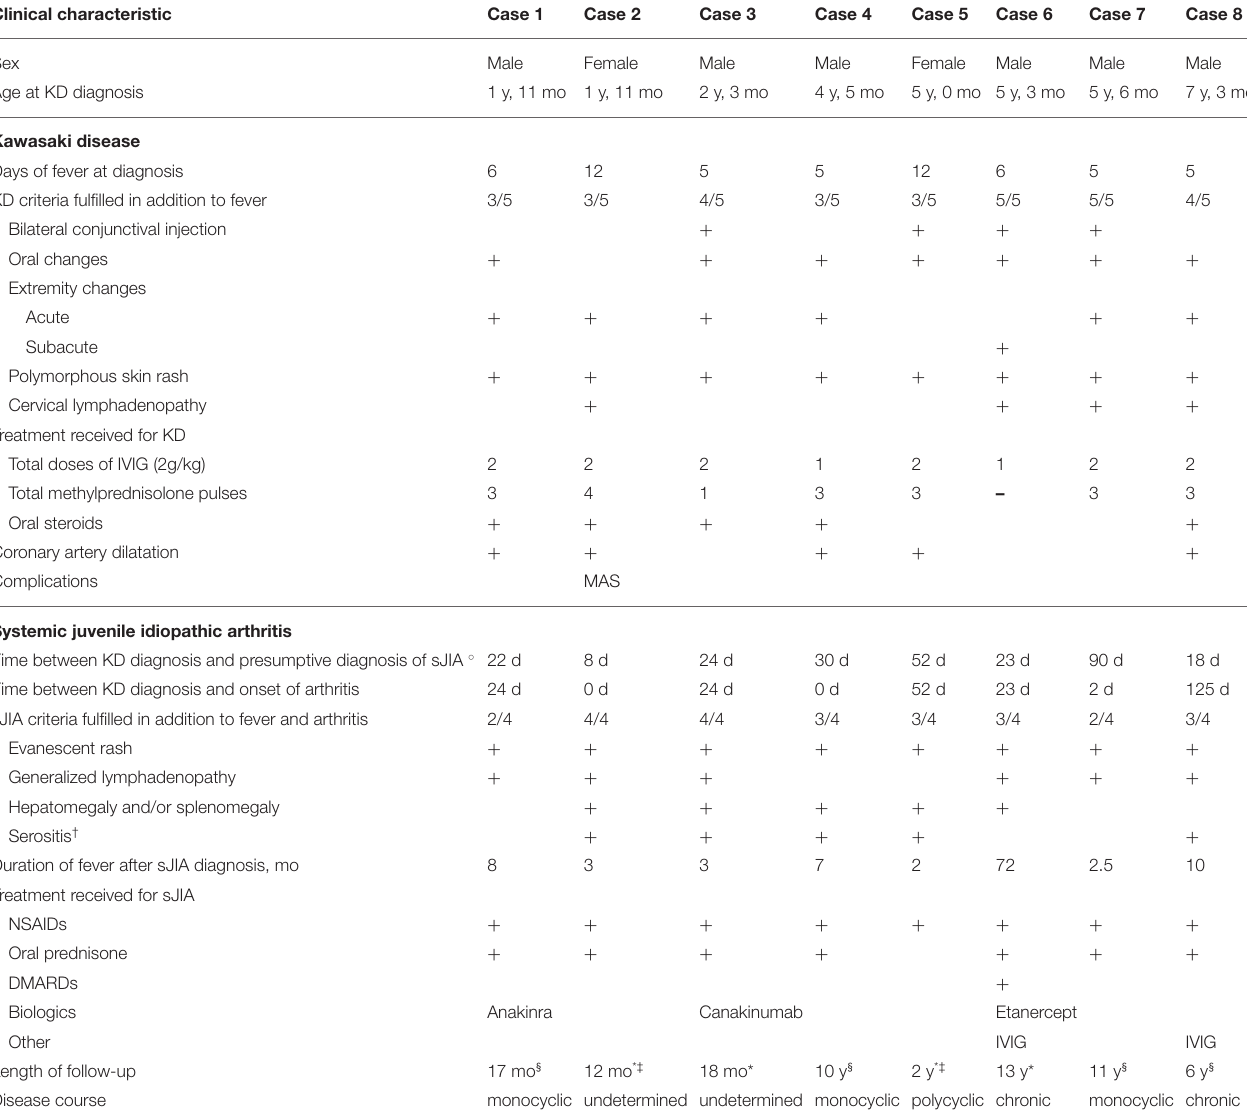
TABLE 2 | Clinical characteristics of KD/sJIA patients. Clinical